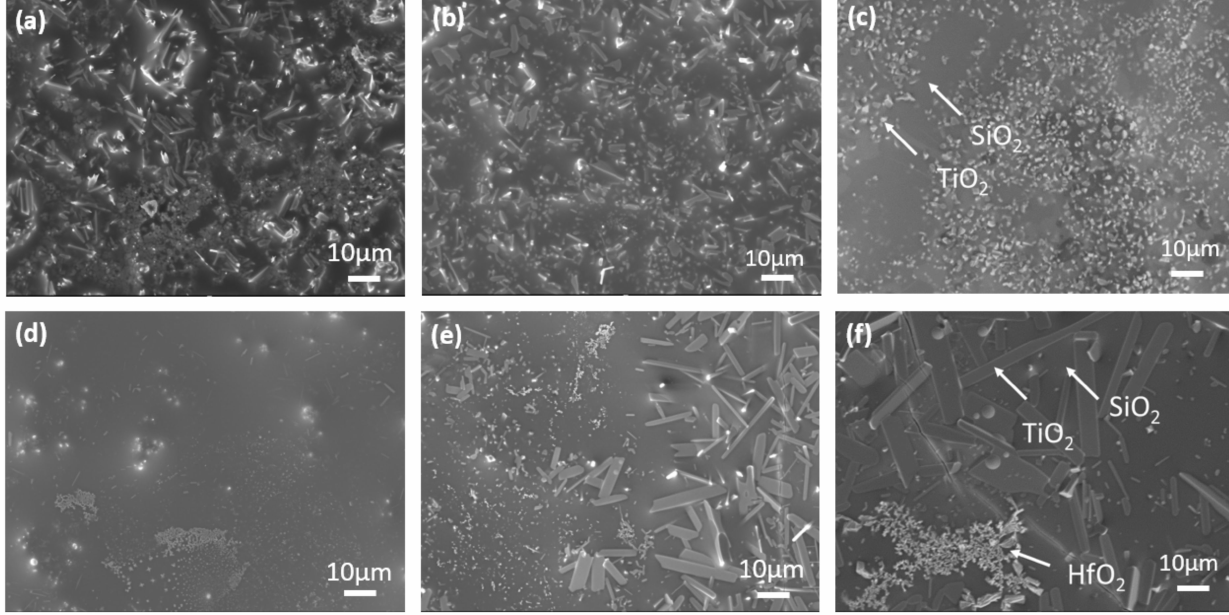
Figure 6. SE image of surface morphologies of oxidized B modified silicides coatings prepared with Al 2 O 3 ( a – c ) and SiO 2 ( d – f ) after oxidation at 1250 ◦ C for 1 h ( a , d ), 10 h ( b , e ), and 100 h ( c , f